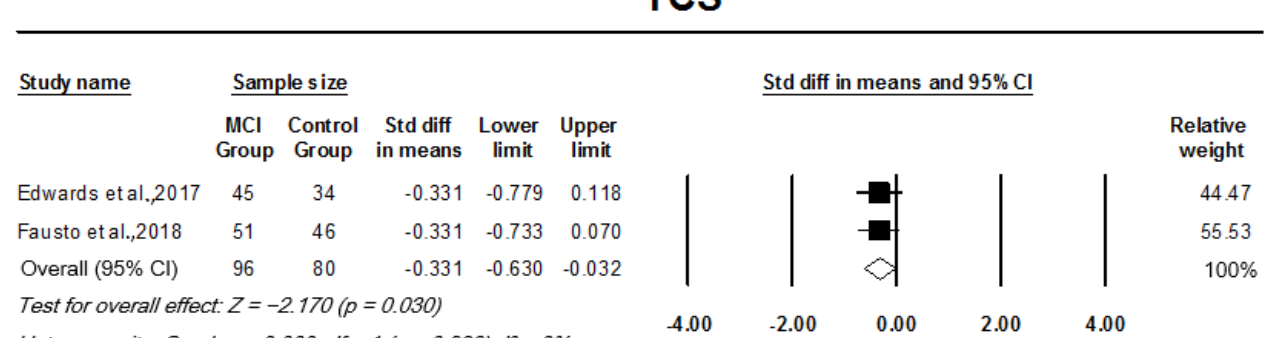
Figure 8. Forest plot of standard mean difference and overall (pooled) estimate of studies investi- gating time-compressed speech (TCS) test (average of 45% and 65% compression) that compare a mild cognitive impairment (MCI) group to a control group. Notes: Z = Z score; I 2 = percentage of heterogeneity; Q-value = Cochrane’s Q; df = degrees of freedom. The horizontal lines represent the 95% confidence interval (CI) for each computed standard mean difference. Weights are from the random-effects analysis. Table 2. Qualitative assessment results for quantitative studies included in the review ( n =